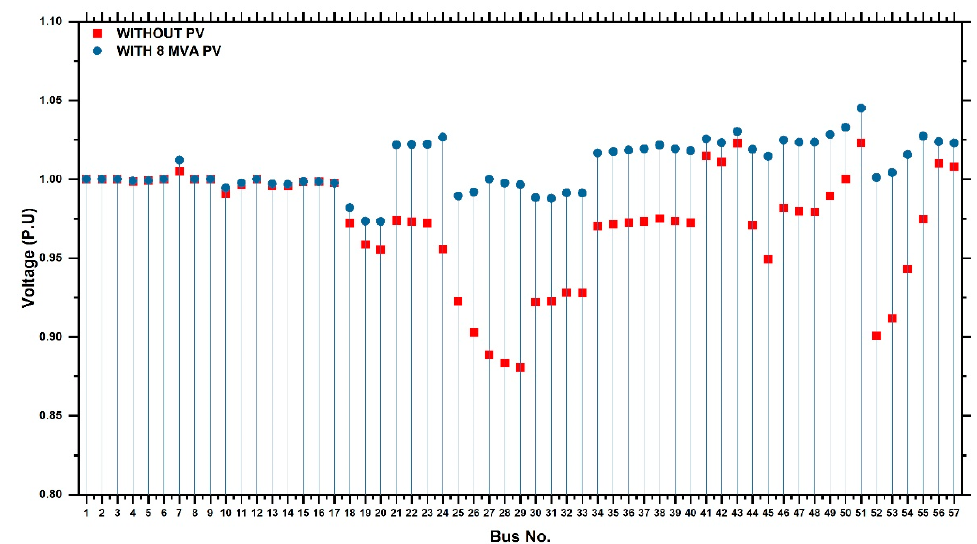
Figure 15. 8 MVA—voltage profile with and without a photovoltaic generator.